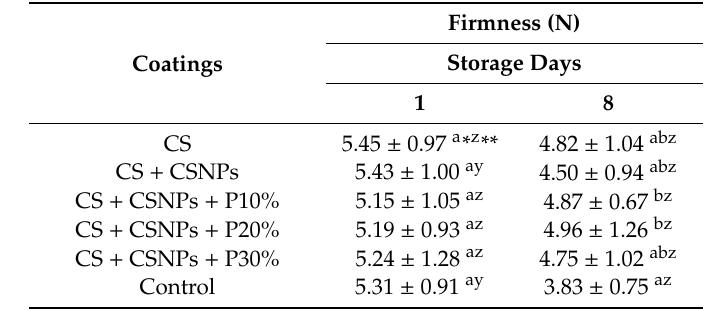
Table 2. Firmness values of strawberry fruit treated with nanostructured chitosan coatings and propolis extract during eight days of